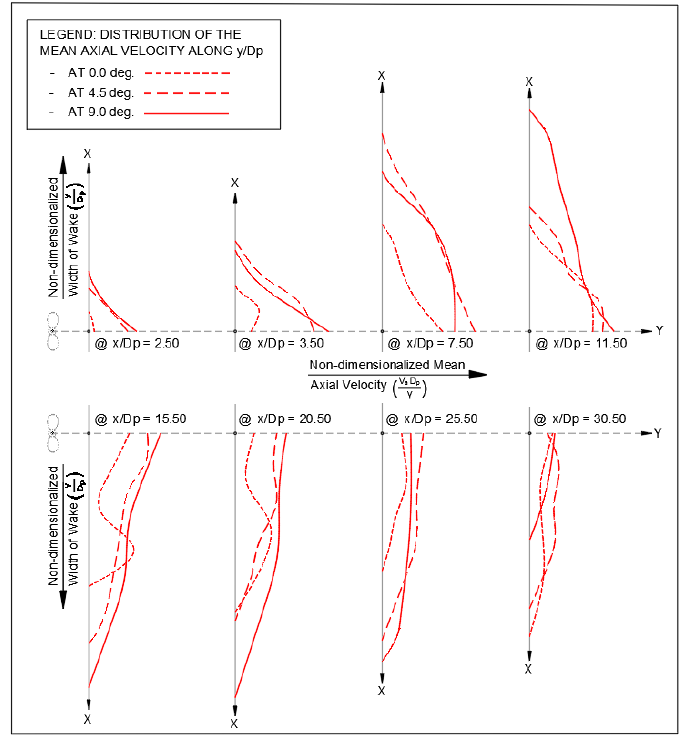
Figure 6. The approximate patterns of the distribution of the non-dimensionalized mean axial velocities (cid:4672) (cid:2906) (cid:3159) (cid:2888) (cid:3148) (cid:2973) (cid:16) (cid:17) (cid:4673) along y/Dp with the change of ‘ θ ’.